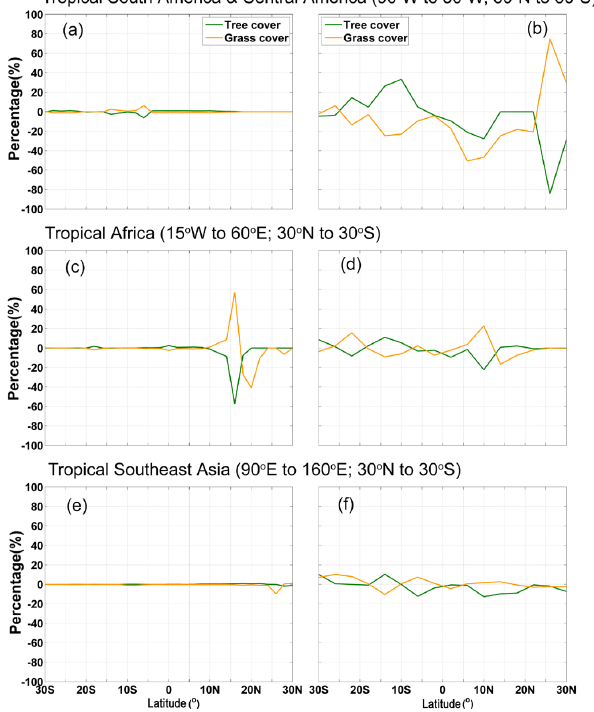
Fig. 3. Annual mean anomalies of regional zonally averaged tree and grass cover between HE1 and LGM for the UVic ESCM (left panels) and the CCSM3 (right panels). The regional areas are tropi- cal South America and Central America (top), tropical Africa (mid- dle) and tropical Southeast Asia